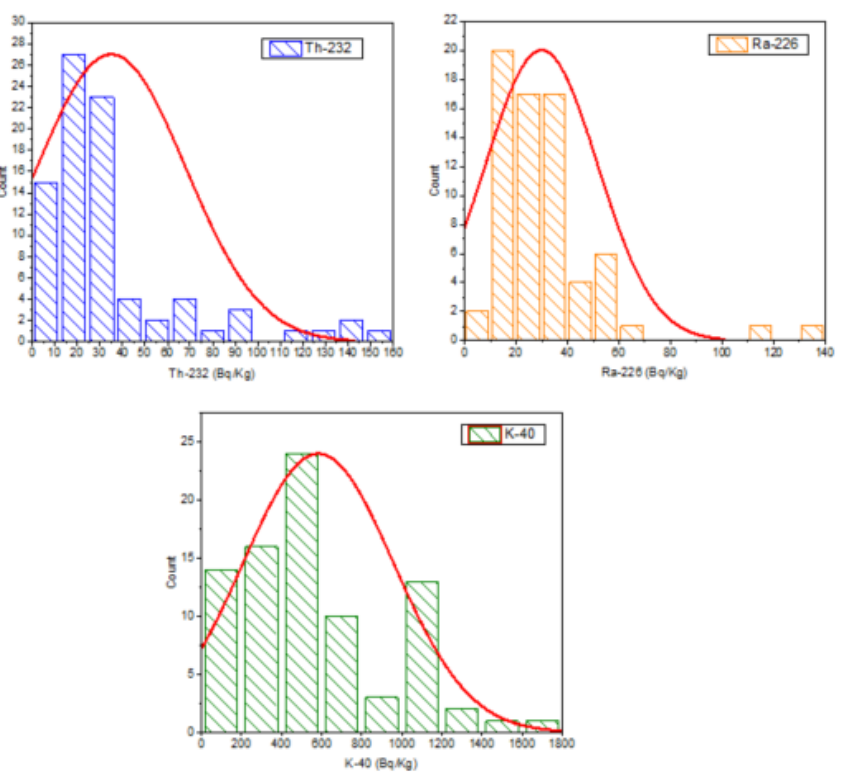
Figure 4. Frequency distribution of the 232 Th, 226 Ra, and 40 K, respectively, in the, studied rock sam- ples.